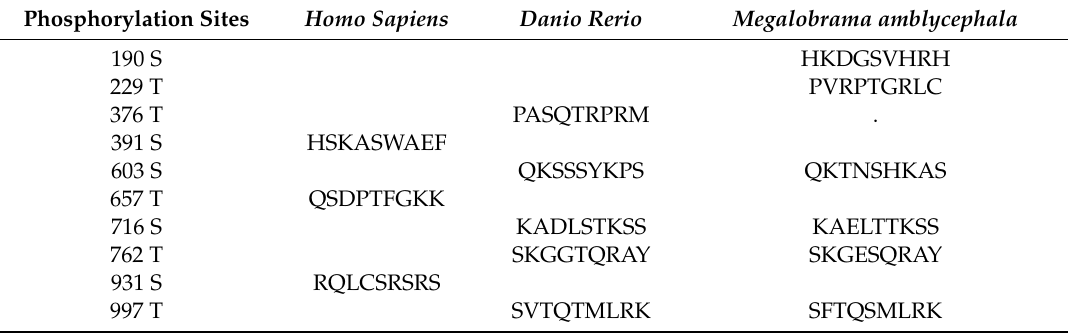
Table 1. The putative phosphorylation sites of peroxisome proliferator-activated receptor-gamma coactivator-1 β (PGC-1 β ) proteins in fish and